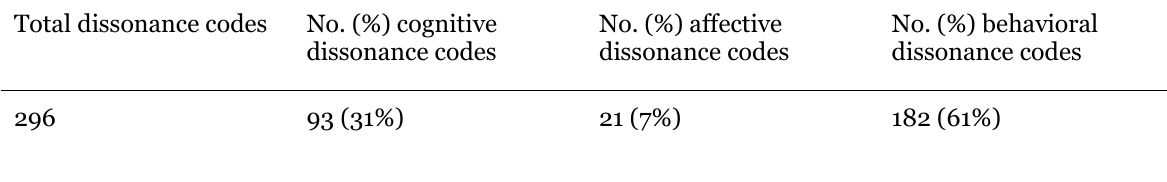
Instructor Dissonance Codes Distribution